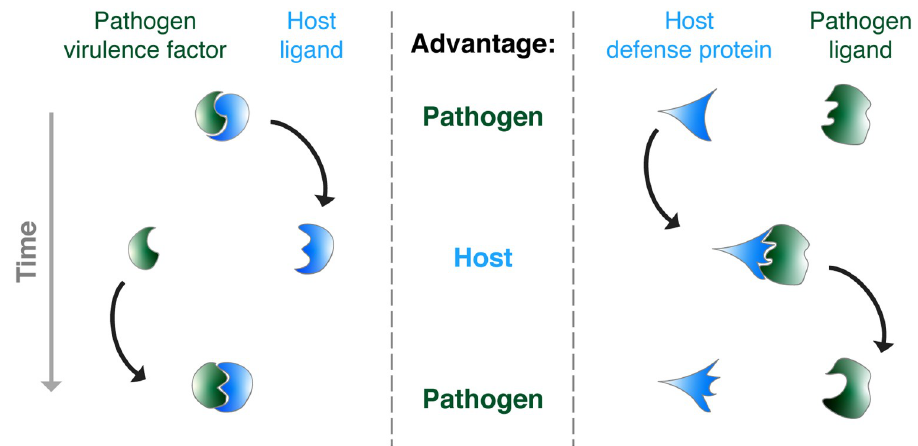
Fig 1. Conceptual overview of host–pathogen evolutionary conflicts. Natural selection in microbial pathogens (green) is predicted to favor mutations that either enhance the activity of virulence factor proteins (left panel) or avoid detection by host immune defenses (right panel). Conversely, mutations in host proteins (blue) that counteract virulence factors or enhance detection of microbial ligands are also predicted to quickly adapt due to positive selection. These antagonistic molecular interactions can give rise to evolutionary conflicts in which neither host nor pathogen ever gains a permanent advantage. Black arrows represent the continual processes of mutation and selection that fuel evolutionary conflicts.